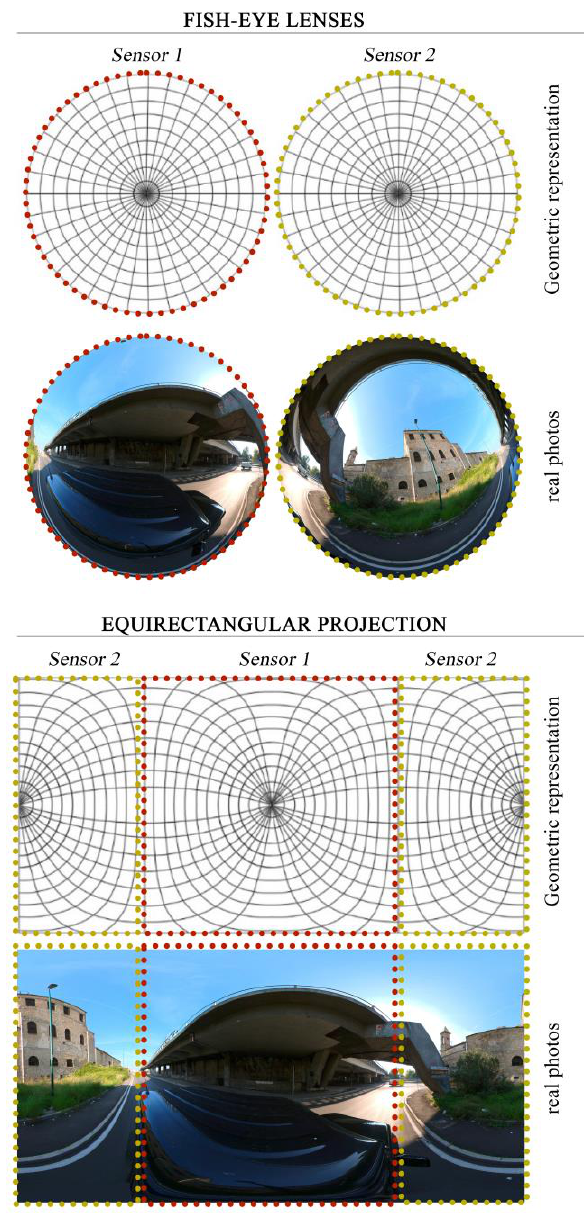
Figure 3 . Geometric configuration of the equirectangular projection generated using fish-eye lenses by Insta360